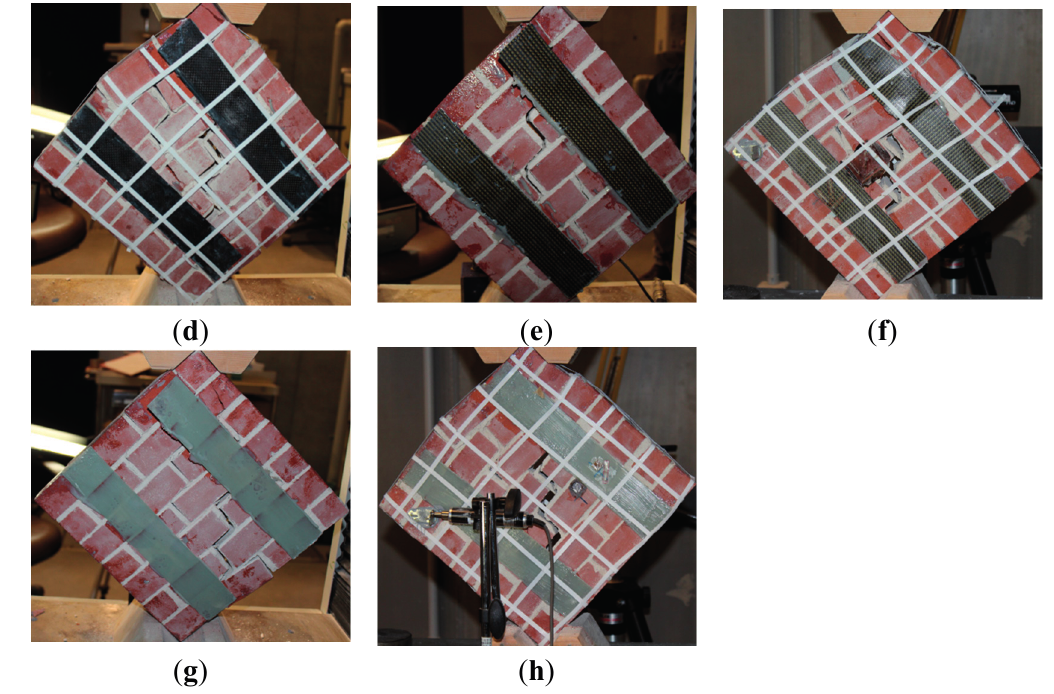
Figure 3. Failure mode and cracking pattern of masonry panels under diagonal compression test for ( a ) URM, ( b ) PP-band retrofitted, ( c ) CFRP retrofitted, ( d ) CFRP +